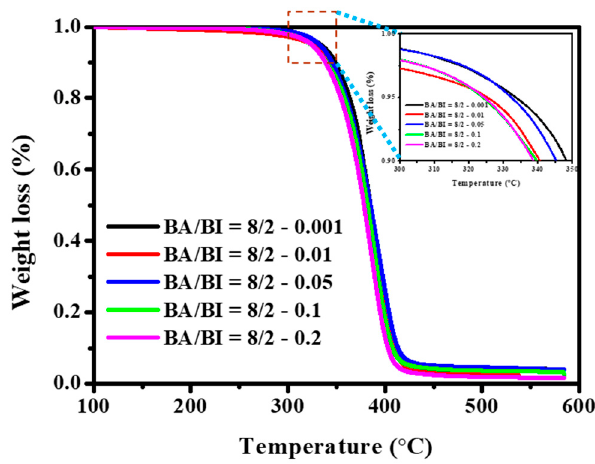
Figure 12. Thermogravimetric analysis (TGA) curve of the PBABI copolyesters with different concentrations of EDTA.